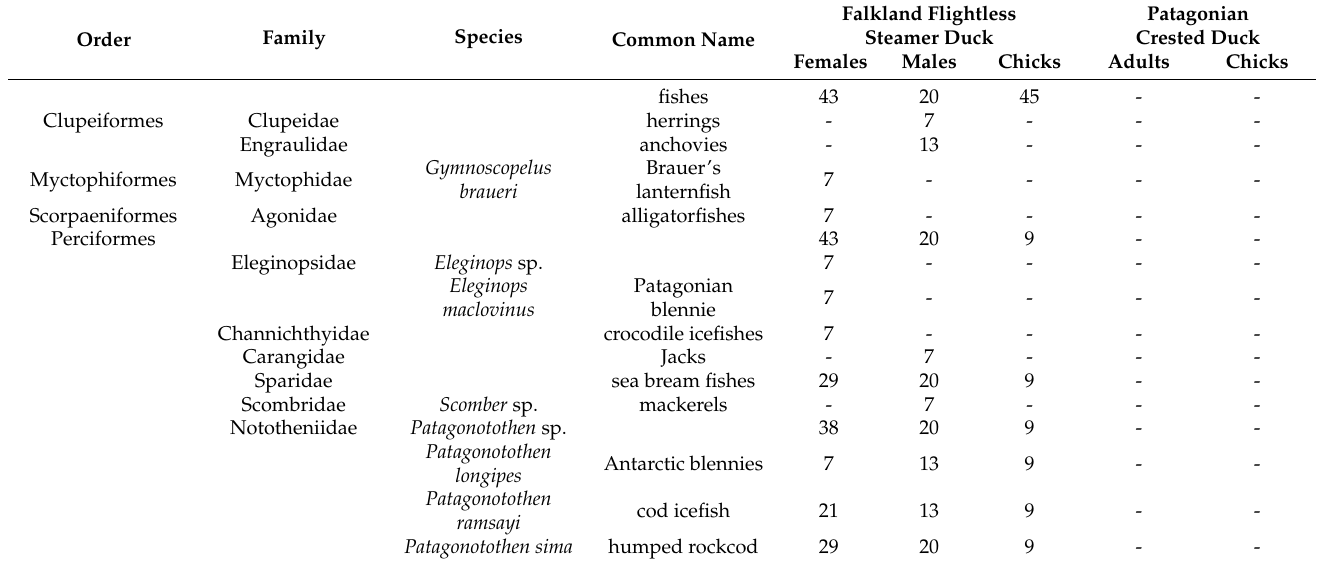
Table 3. Actinopterygii (fishes) consumed by Falkland Flightless Steamer Duck Tachyeres brachydactyla and Patagonian Crested Duck Lophonetta specularoides , and frequency of occurrence (% of